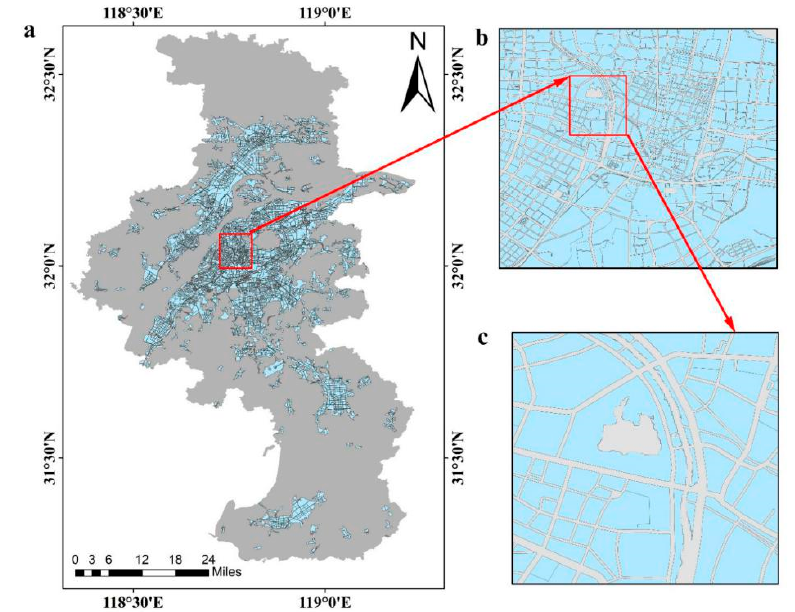
Figure 4. Urban land parcels of Nanjing. ( a ) Overall pattern, ( b ) and ( c ) are detailed zoomed-in views of urban land parcels.